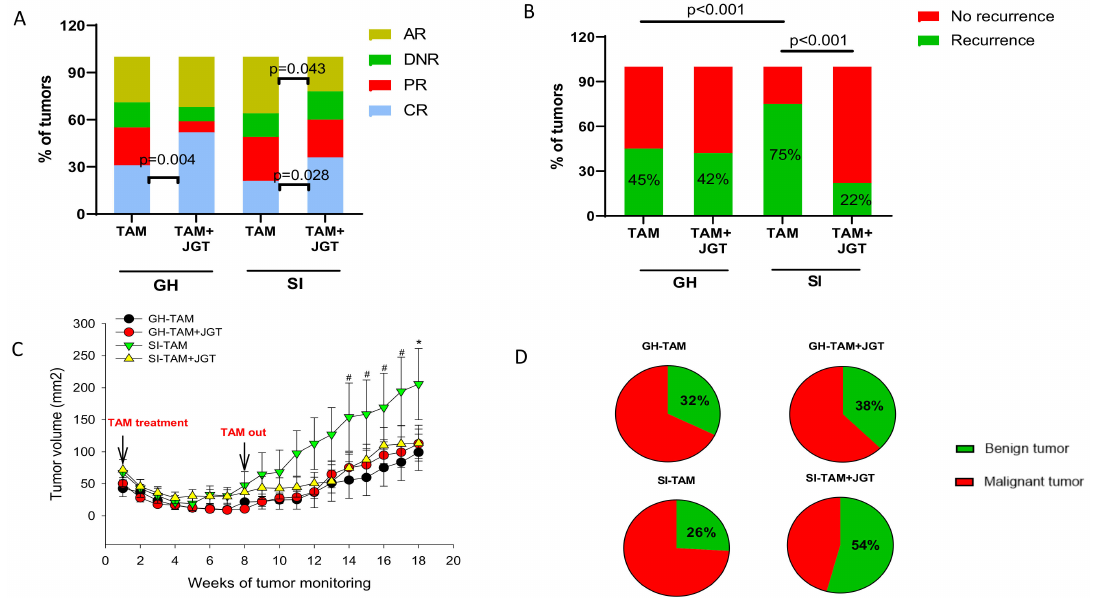
Figure 2. Social isolation increases the risk of local mammary tumor recurrence, and JGT reverts it. ( A ) Percentage of complete responses (CR; blue), partial responses (PR; red), de novo resistant (DNR; green), and acquired resistant mammary tumors (AR; yellow) in group-housed (GH) rats treated with tamoxifen (TAM) ( n = 58 tumors) or with TAM+ Jaeumganghwa-tang (JGT) ( n = 44 tumors), and in socially isolated (SI) rats treated with TAM ( n = 39 tumors) or with TAM + JGT ( n = 45 tumors). Treatment with JGT increased TAM responsiveness in GH ( χ 2 ; p = 0.004) and SI rats ( χ 2 ; p = 0.03). ( B ) TAM therapy ended after a complete response was maintained for approximately 9 weeks, and then local mammary tumor recurrences (green) were monitored. Social isolation increased recurrence ( χ 2 ; p < 0.001) and JGT reversed the increase ( χ 2 ; p < 0.001). ( C ) After TAM therapy, mammary tumor burden, assessed by measuring the tumor volume (calculated by diameter × width, and sum of all tumor volumes per animal was a tumor burden), was significantly higher in SI rats compared to other groups. Differences were analyzed according to 2-way repeated measures ANOVA followed by the Tukey test. # Indicates statistical significance during weeks when it reached p < 0.05 for GH-TAM vs. SI-TAM. * Indicates statistical significance during weeks when it reached p < 0.05 for GH-TAM vs. SI-TAM and SI-TAM vs. SI-T + J. Means ± SEM of tumor volume at each tumor monitoring week are shown. ( D ) Tumor histopathology showing that JGT significantly increased ( χ 2 ; p < 0.001) the proportion of benign tumors in SI animals from 26% (7 of 27 tumors) to 54% (13 of 24